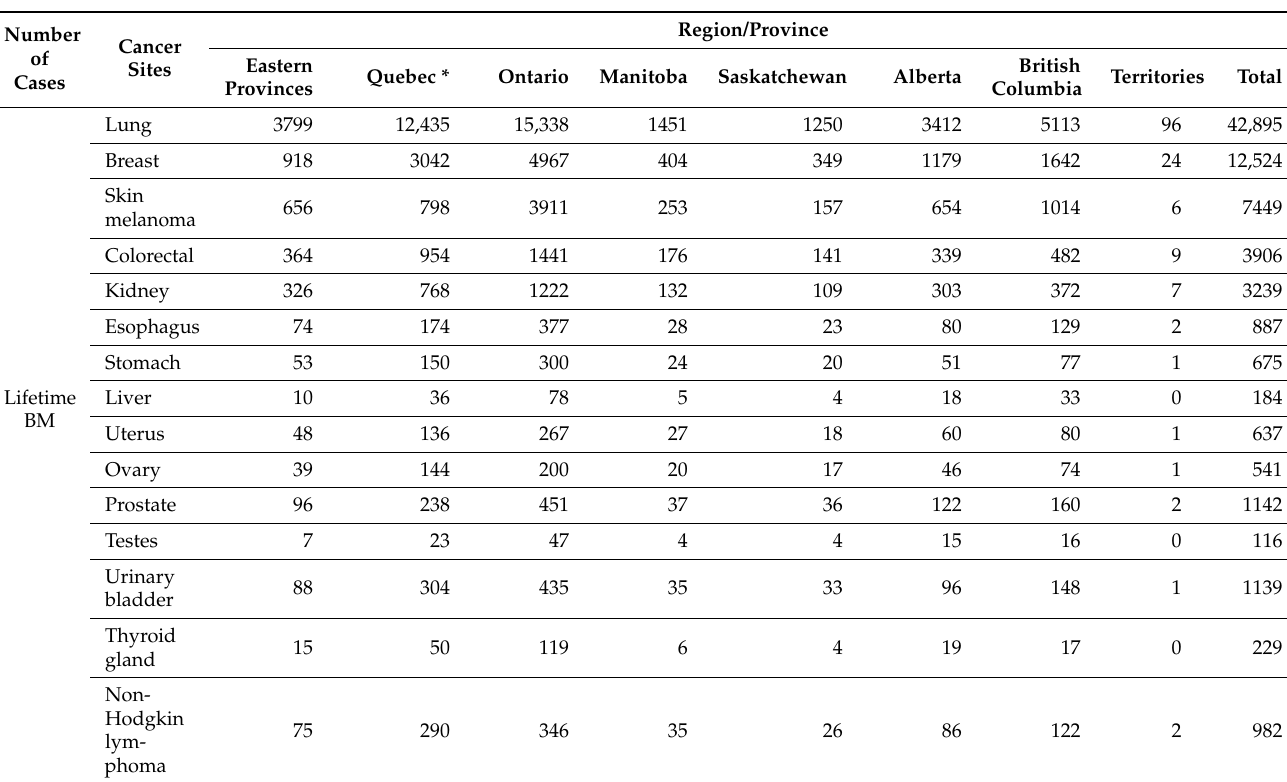
Table A4. Average number of lifetime brain metastases by provinces/territories among cancer patients diagnosed in Canada (2010–2017) by primary cancer